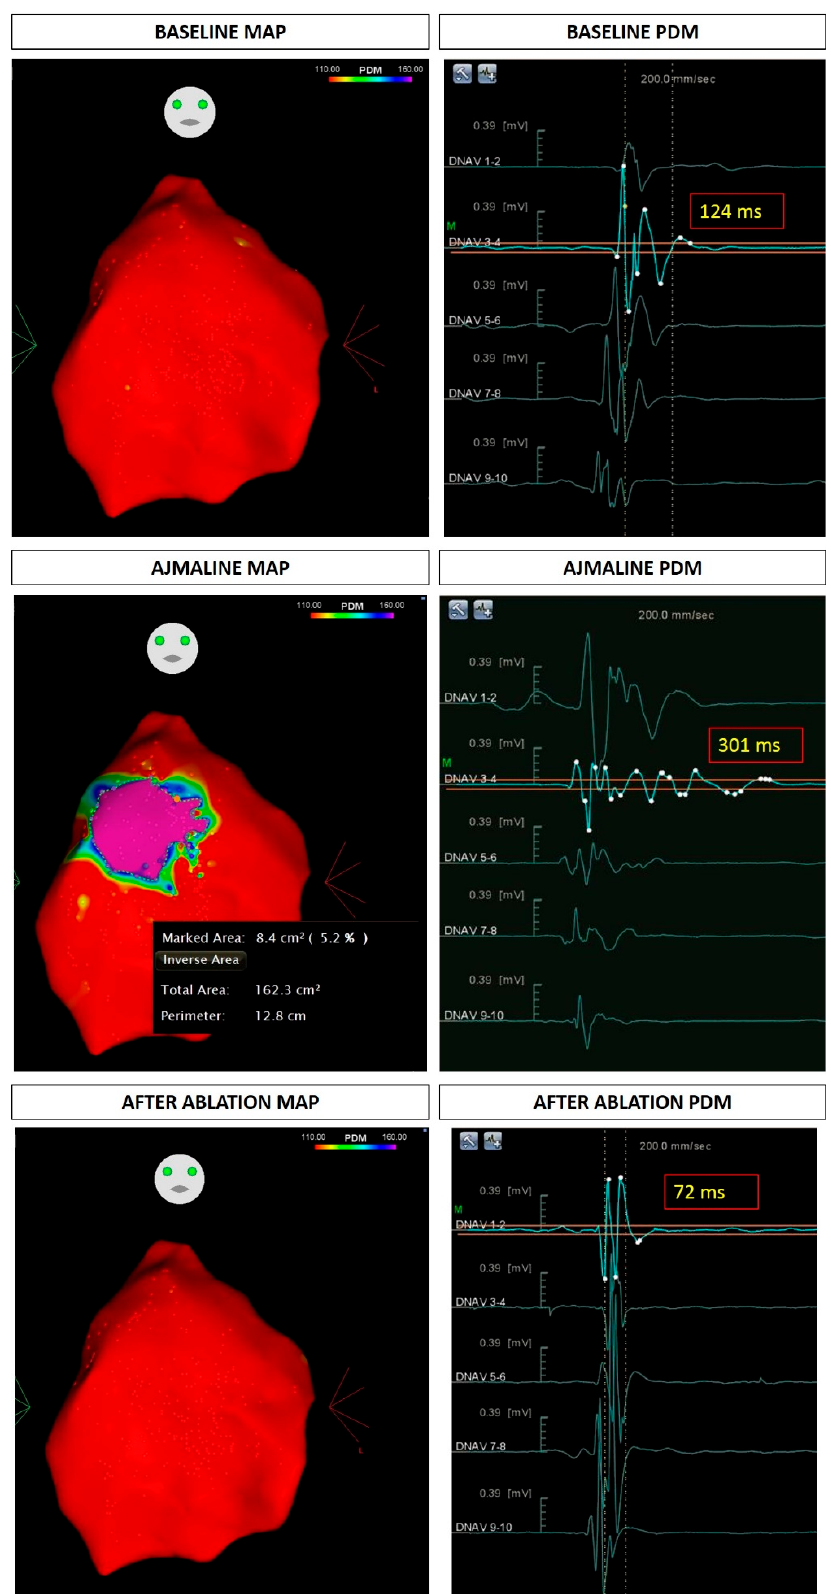
Figure 3. Epicardial arrhythmogenic substrate and duration of fragmented potentials in the proband at baseline, after the administration of ajmaline, and after ablation. PDM: potential duration map.